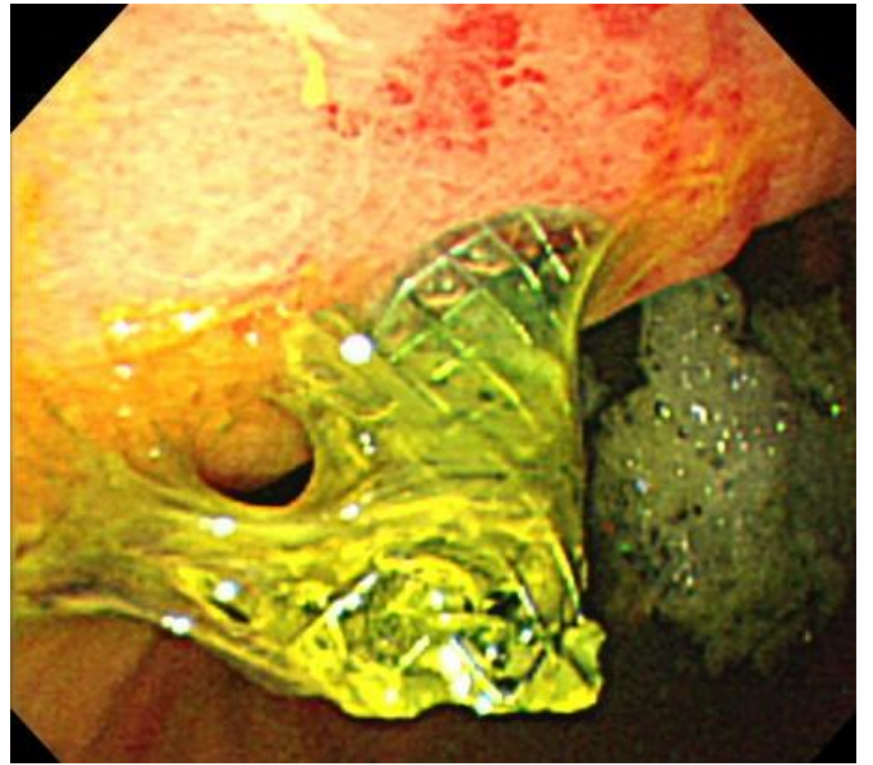
Figure 3. An endoscopic image of the patient shown in Figure 2. The stomach stent is very short and is about to fall